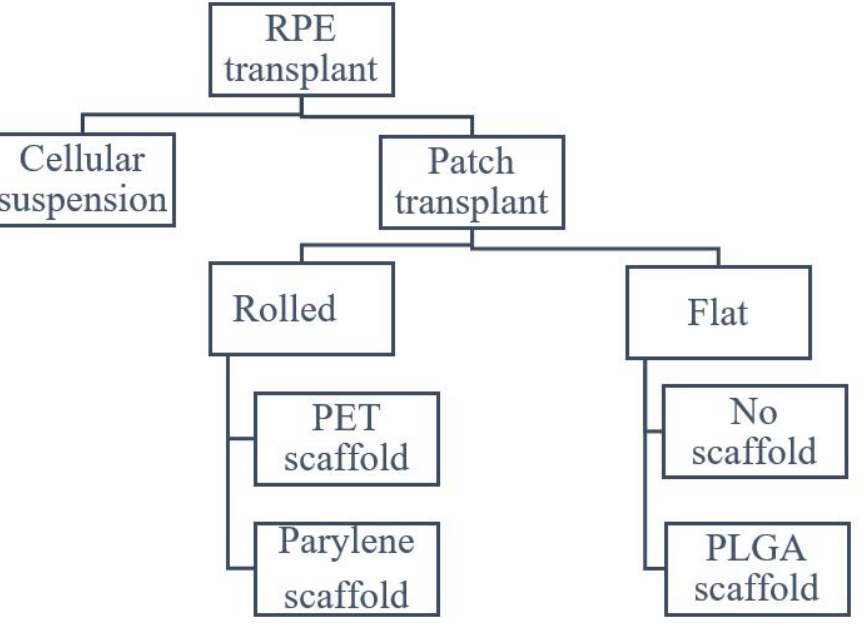
Figure 1. Scheme of possible RPE transplant delivery